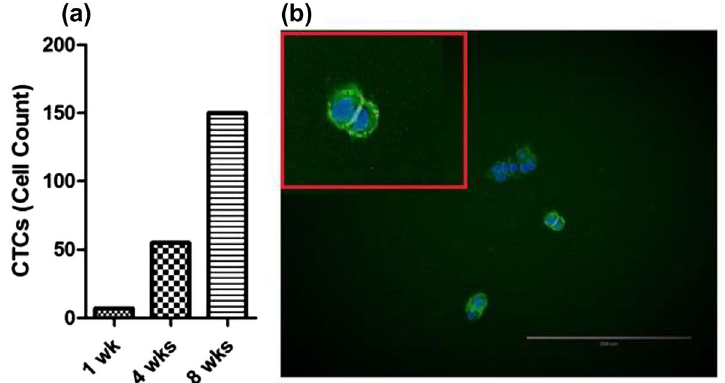
Figure 7. Characterisation of Epithelial-Like CTCs derived from the blood of a breast cancer patient. The figure illustrates the number of CTCs grown over time (1 wk, 4 wks and 8 wks) in culture as measured by hemocytometry. ( b ) Immunostaining revealed that epithelial-like CTCs express EpCAM at 8 weeks. Cells were stained with Hoechst 33342, blue for nuclear visualisation. Imaging was performed using an inverted microscope